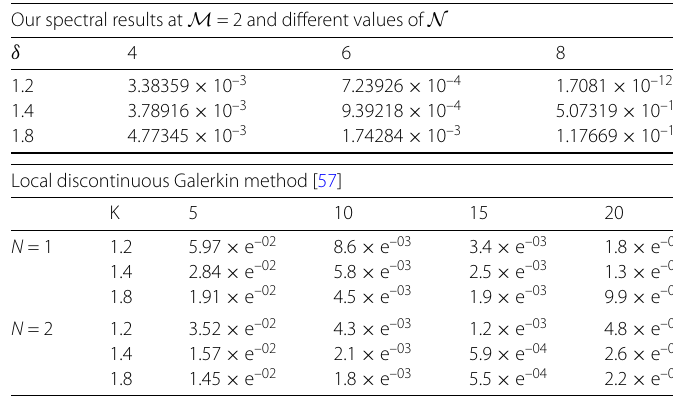
Table 1 L 2 -comparison for problem (1) Our spectral results at M = 2 and different values of